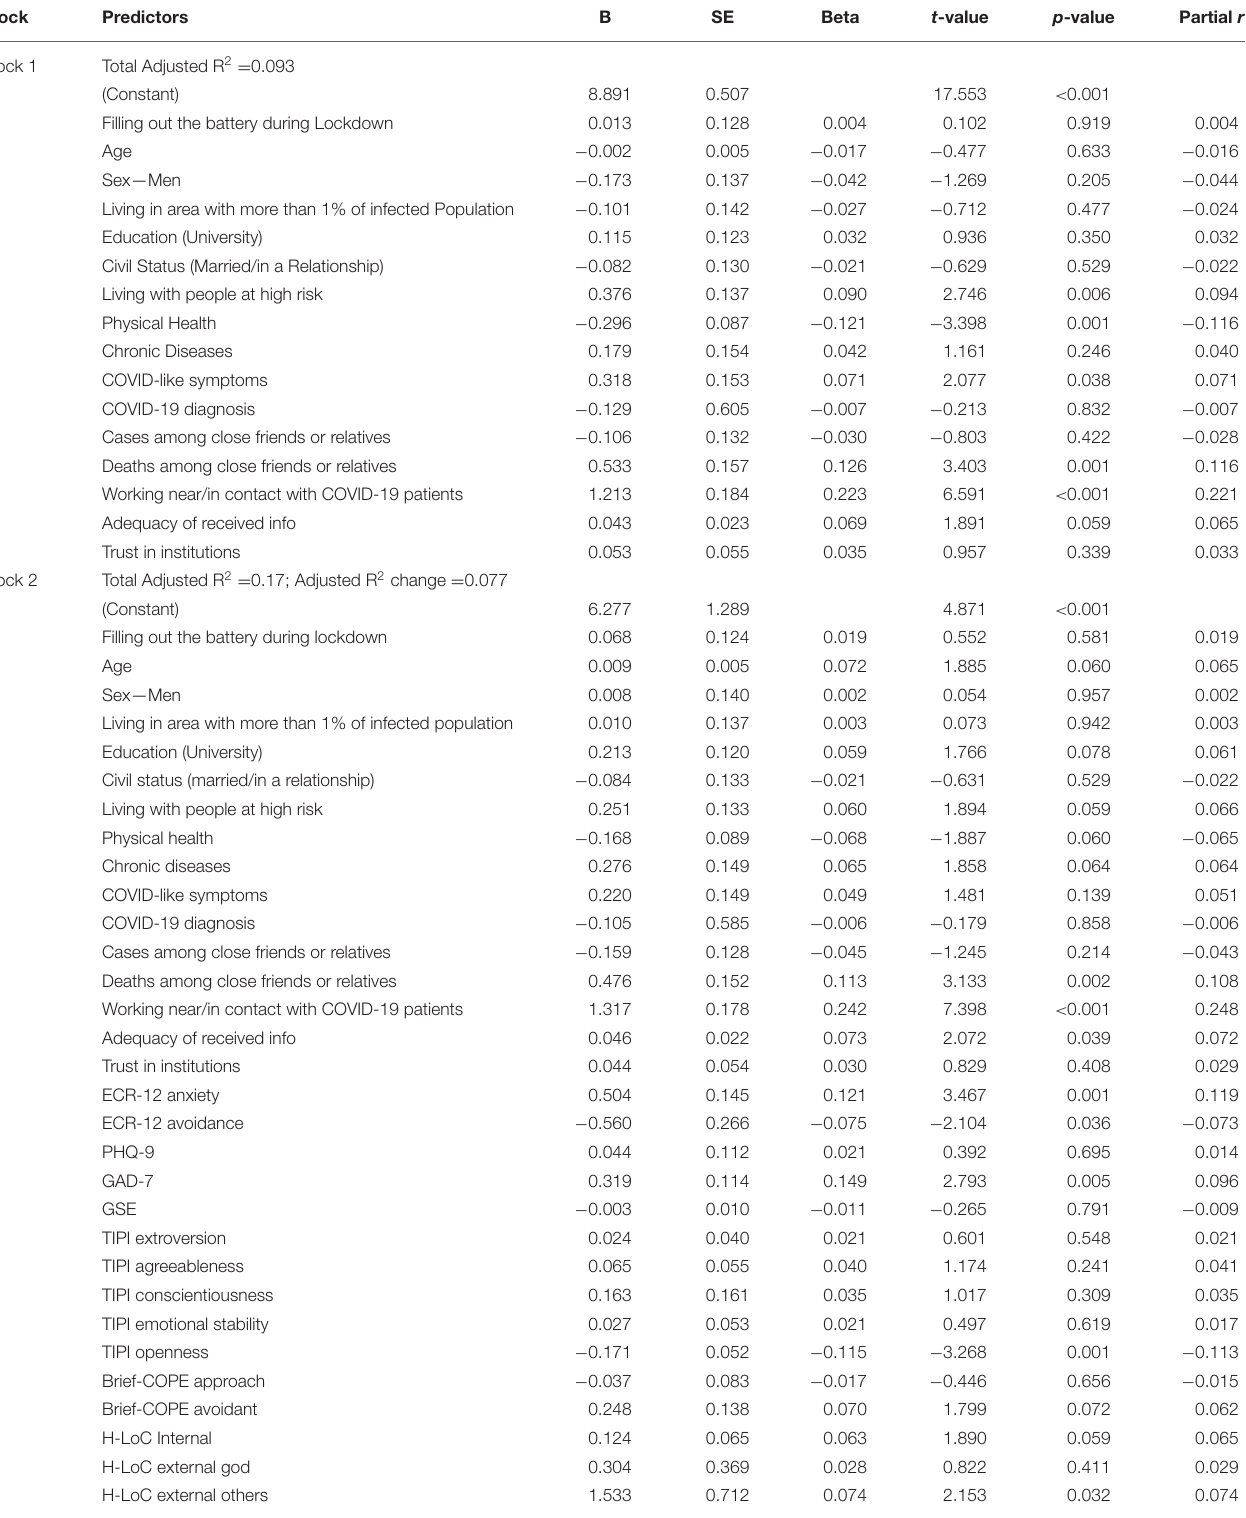
TABLE 2 | Unstandardized B, Standard Errors, Standardized Beta, t -values, p -values and partial r correlation coefficient of the sociodemographic, epidemiological and psychological predictors of Risk Perception, in the total sample of 907 Italian participants.